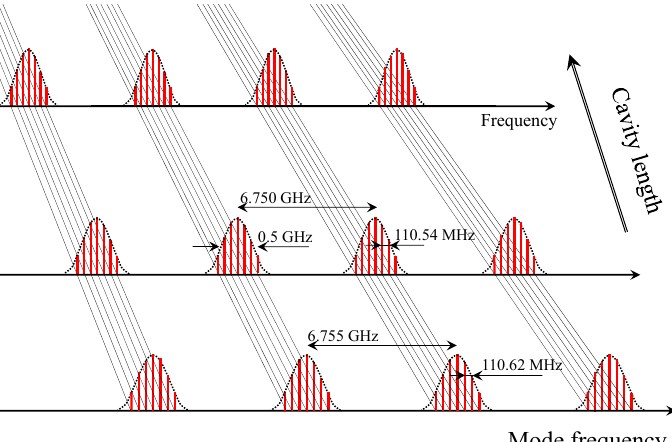
Figure 1. A schematic of a Ti:Sapph oscillator, pumped by a 532 nm source. A simple etalon nested in the oscillator is depicted at an exaggerated angle (typical angles are from 0 mrad to 20 mrad). One end mirror uses a standard semiconductor multiple quantum well (MQW) to assist mode-locking. The output of this cavity is sent to a 87 Rb vapor cell for the characterization experiments that are described in a later section. A Photo Multiplier Tube (PMT) is used to collect the fluorescence of the vapor cell as the laser elements are scanned.